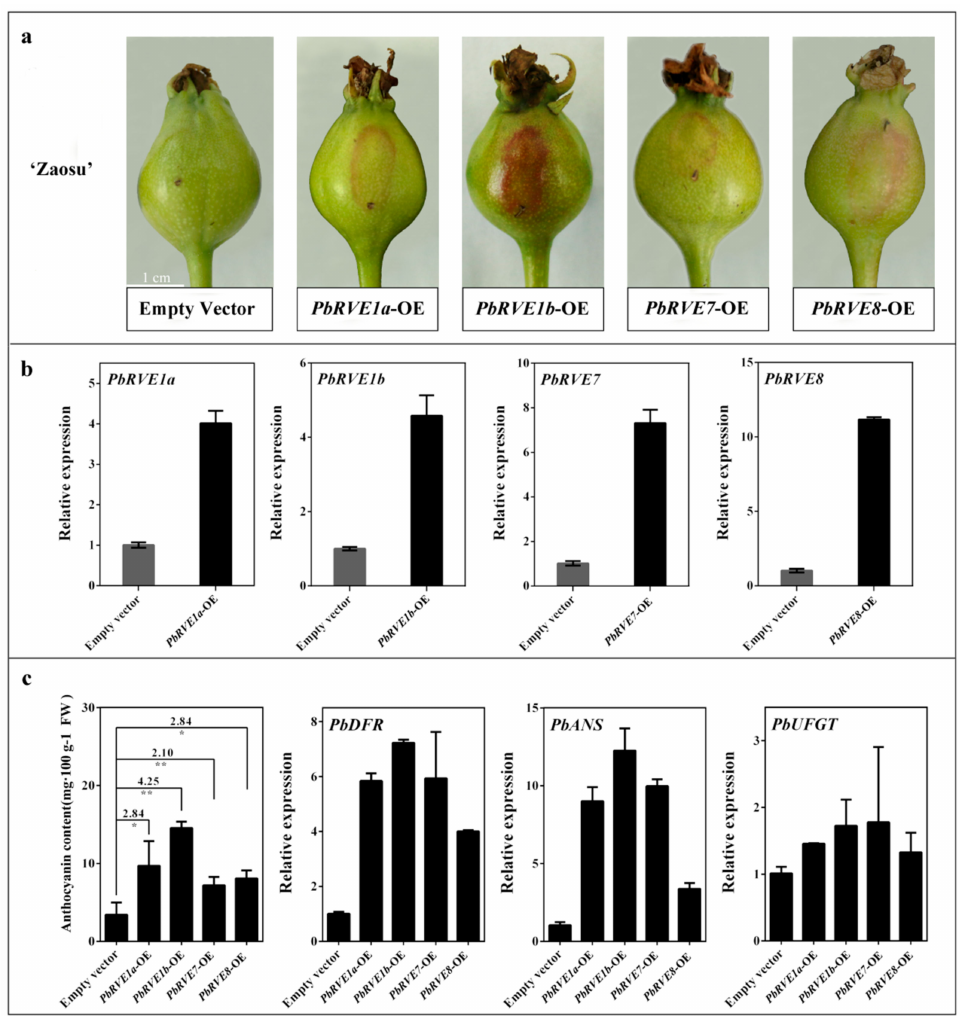
Figure 4. Anthocyanin biosynthetic patterns in RVE -overexpression. ( a ) Phenotypes of ‘Zaosu’ fruitlet skins transiently overexpressing PbRVE1a , 1b , 7 and 8 . ( b ) The overexpression levels of PbRVE1a , 1b , 7 and 8 in ‘Zaosu’ fruitlet skins. ( c ) The anthocyanin contents and the expression patterns of ALBG s in ‘Zaosu’ fruitlet skins which overexpressing PbRVEs . The number means the ratio of anthocyanin content in ‘Zaosu’ fruitlets skin overexpressing PbRVE s compared with the empty vector. OE: overexpression. The significant di ff erences are based on comparisons with the empty vector. Error bars indicate the SEs of the means ( n = 3). Data in (c) were analyzed using Student’s t -test: * p < 0.05, ** p <